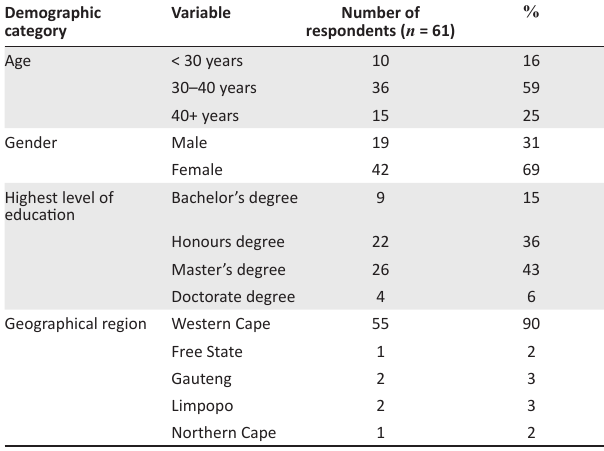
TABLE 3: Demographic composition of respondents.